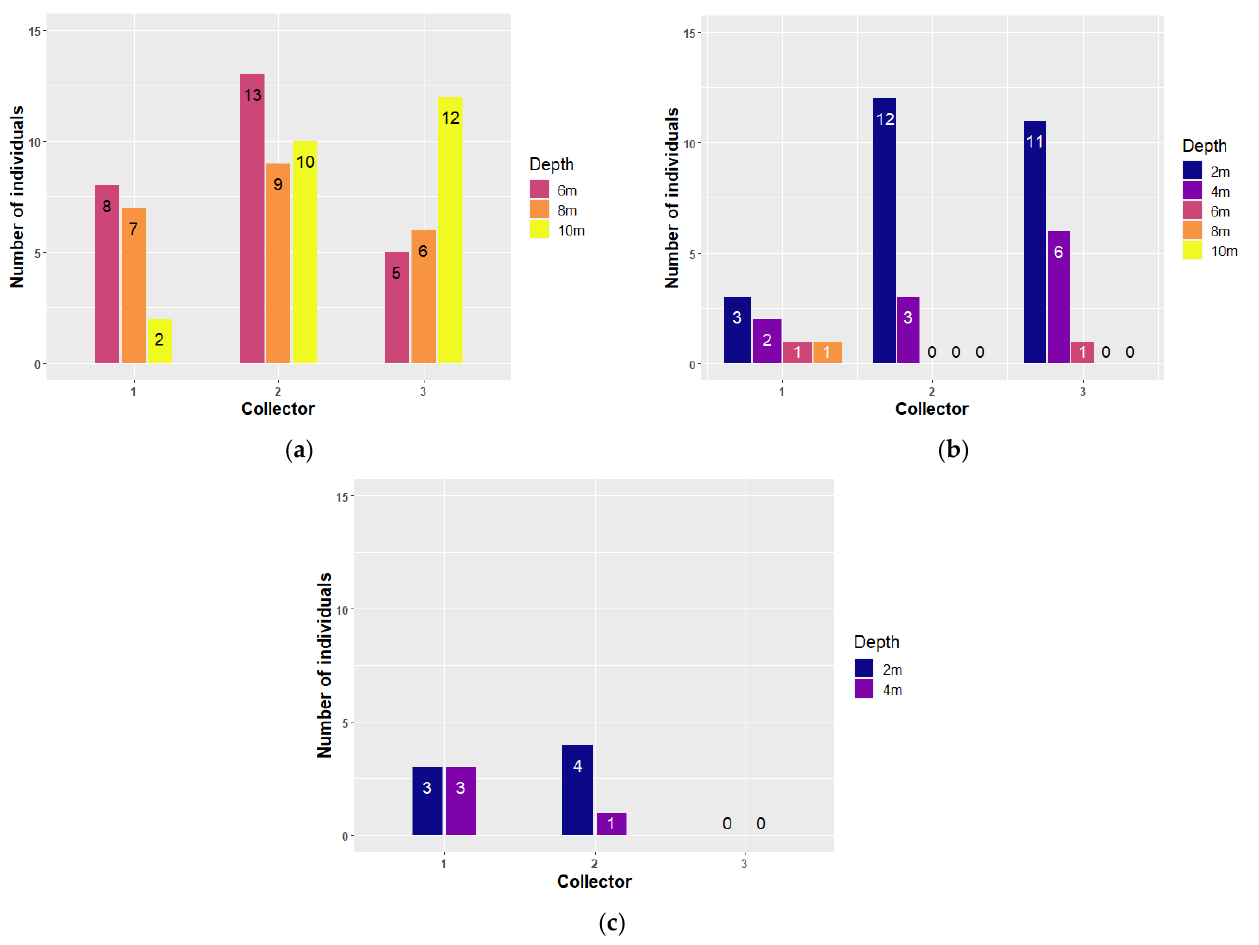
Figure 6. Number of juvenile Pinna nobilis on larval collectors according to depth ( a ) in Javorike Cove in 2019 ( n = 72), ( b ) in Javorike Cove in 2020 ( n = 40) and ( c ) in Pisak Cove in 2020 ( n = 11); all Pinnas found on collectors were taken into account.